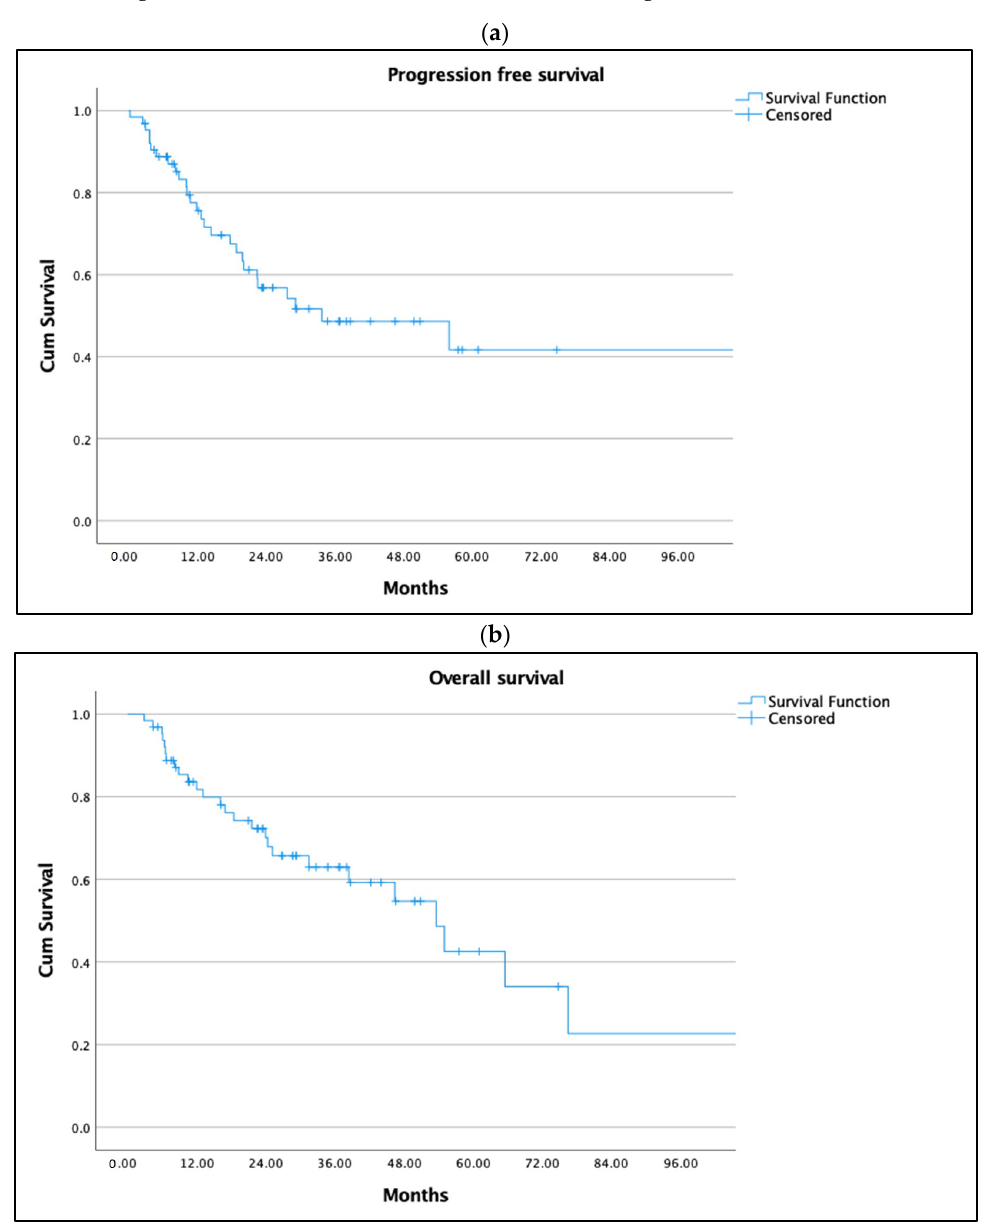
Figure 1. ( a ) Progression free survival and ( b ) overall survival of study cohort. All 184 patients were followed for PFS as presented ( a ) and OS as in ( b ). On univariate Cox proportional hazards analysis, male gender (HR 2.37, 95% CI 1.11– 5.09, p = 0.03) and AFP ≥ 20 ng/mL were negative predictors of PFS (HR 3.73, 95% CI 1.71– 8.13, p < 0.001), whereas increasing albumin was associated with prolonged PFS (HR 0.50, 95% CI 0.27–0.94, p = 0.04). Notably, the albumin to bilirubin (ALBI) ratio demonstrated a near-signi fi cant prediction of PFS with grade 1 scores protective for PFS (HR 0.13, 95% CI 0.15–1.08, p = 0.05) (Table 3).